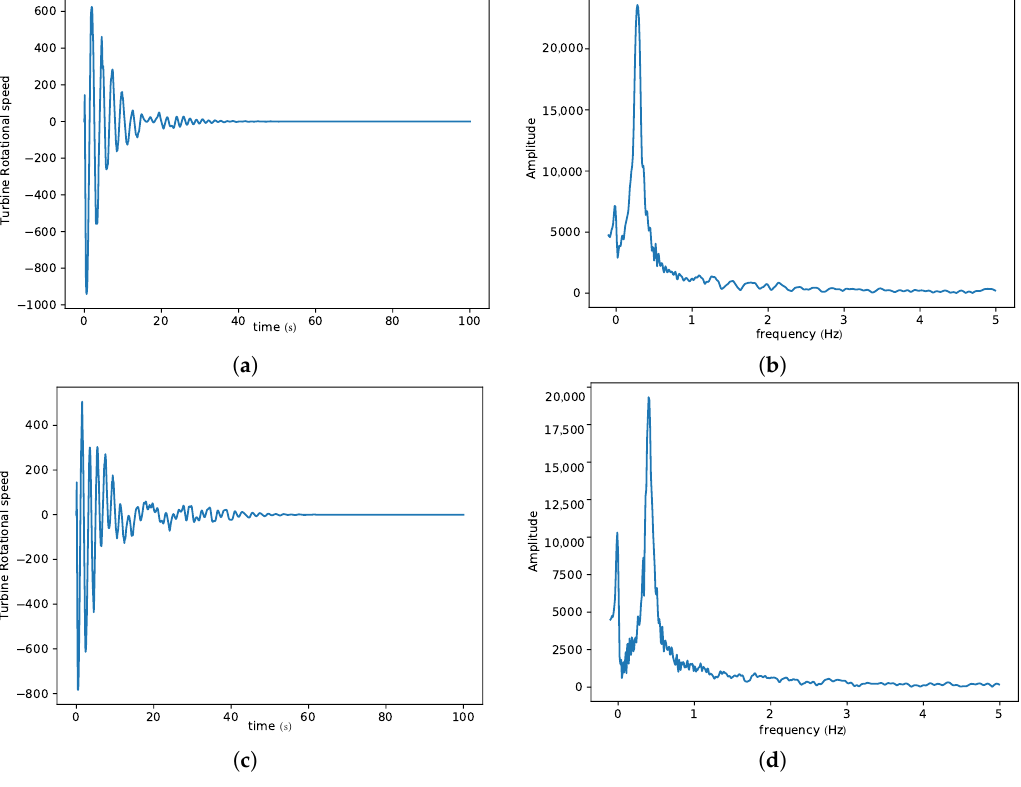
Figure 7. The effect of a bigger helical angle on wind turbine rotational speed ( ˙ θ 1 ). ( a , b ) are the time series and the corresponding FFT frequency spectrum plots for the case β = π /6. In ( c , d ), the helical angle has been set to β = π /12. The other parameters are fixed and listed in Table